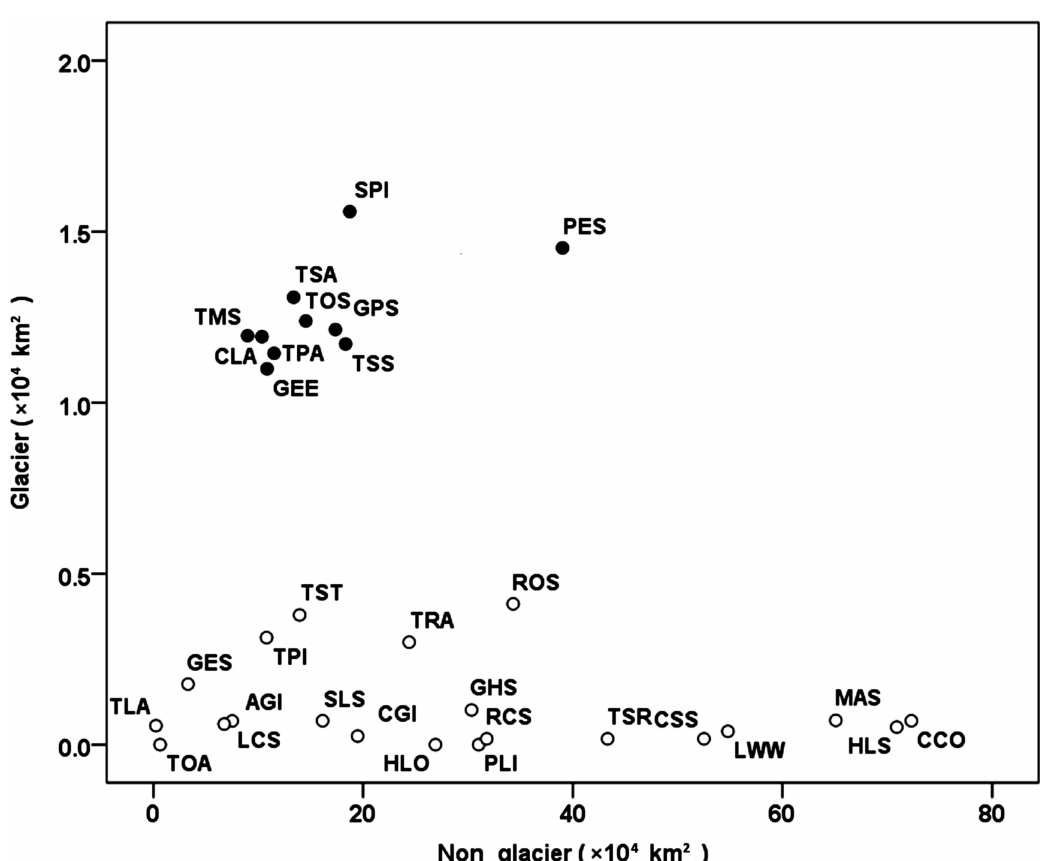
Fig 4. Distribution of fish in the glaciated and non-glaciated areas. The black dots are highly specialisedplateau species that have a higherproportionof distributionalarea in glaciatedareas, and the white circles are species with more ancestralcharacters, which are mostly found in unglaciated areas. PLI, Phoxinus lagowskii ; LCS, Leuciscus chuanchicus ; LWW, Leuciscuswaleckiiwaleckii ; HLS, Hemiculter leucisculus ;AGI, Acanthogobio guentheri ;HLO, Hemibarbus labeo ;GHS, Gobio huanghensis ; RCS, Rhinogobio cylindricus ;CSS, Coreiusseptentrionalis ; ROS, Rhodeusocellatus ;GPS, Gymnodiptychus pachycheilus ; GEE, Gymnocypris ecklonieckloni ;GES, Gymnocypris eckloni scolistomus ; SPI, Schizopygopsis pylzovi ; CLA, Chuanchialabiosa ;PES, Platypharodon extremus ;CCO, Cyprinus carpio ; TOA, Triplophysa obscura ;TOS, Triplophysa orientalis ;TPI, Triplophysa pappenheimi ; TPA, Triplophysa pseudoscleroptera ; TRA, Triplophysa robusta ;TSA, Triplophysa scleroptera ;TSR, Triplophysa sellaefer ; TSS, Triplophysa siluroides ;TLA, Triplophysa leptosoma ;TMS, Triplophysa microps ; TST, Triplophysa stenura ;CGI, Cobitis granoei ;MAS, Misgurnus anguillicaudatus ; SLS, Silurus lanzhouensis